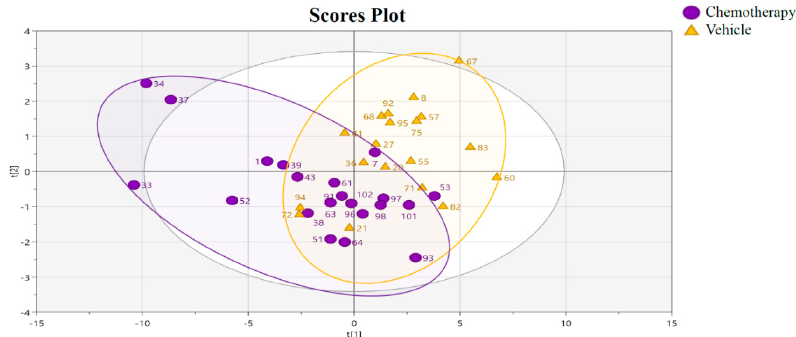
Figure 2. Two dimensional partial least squares-discriminant analysis (PLS-DA) plot with data points representing individual animals treated with chemotherapy (purple dot, n = 21) or vehicle (orange triangles, n = 19), after feature selection (26 metabolites with a VIP score > 1.75 for the first component were retained). R 2 = 71%, Q 2 = 0.275, CV-ANOVA P value = 0.01, and the post-permutation test (200 permutations) Q 2 value = − 0.085.